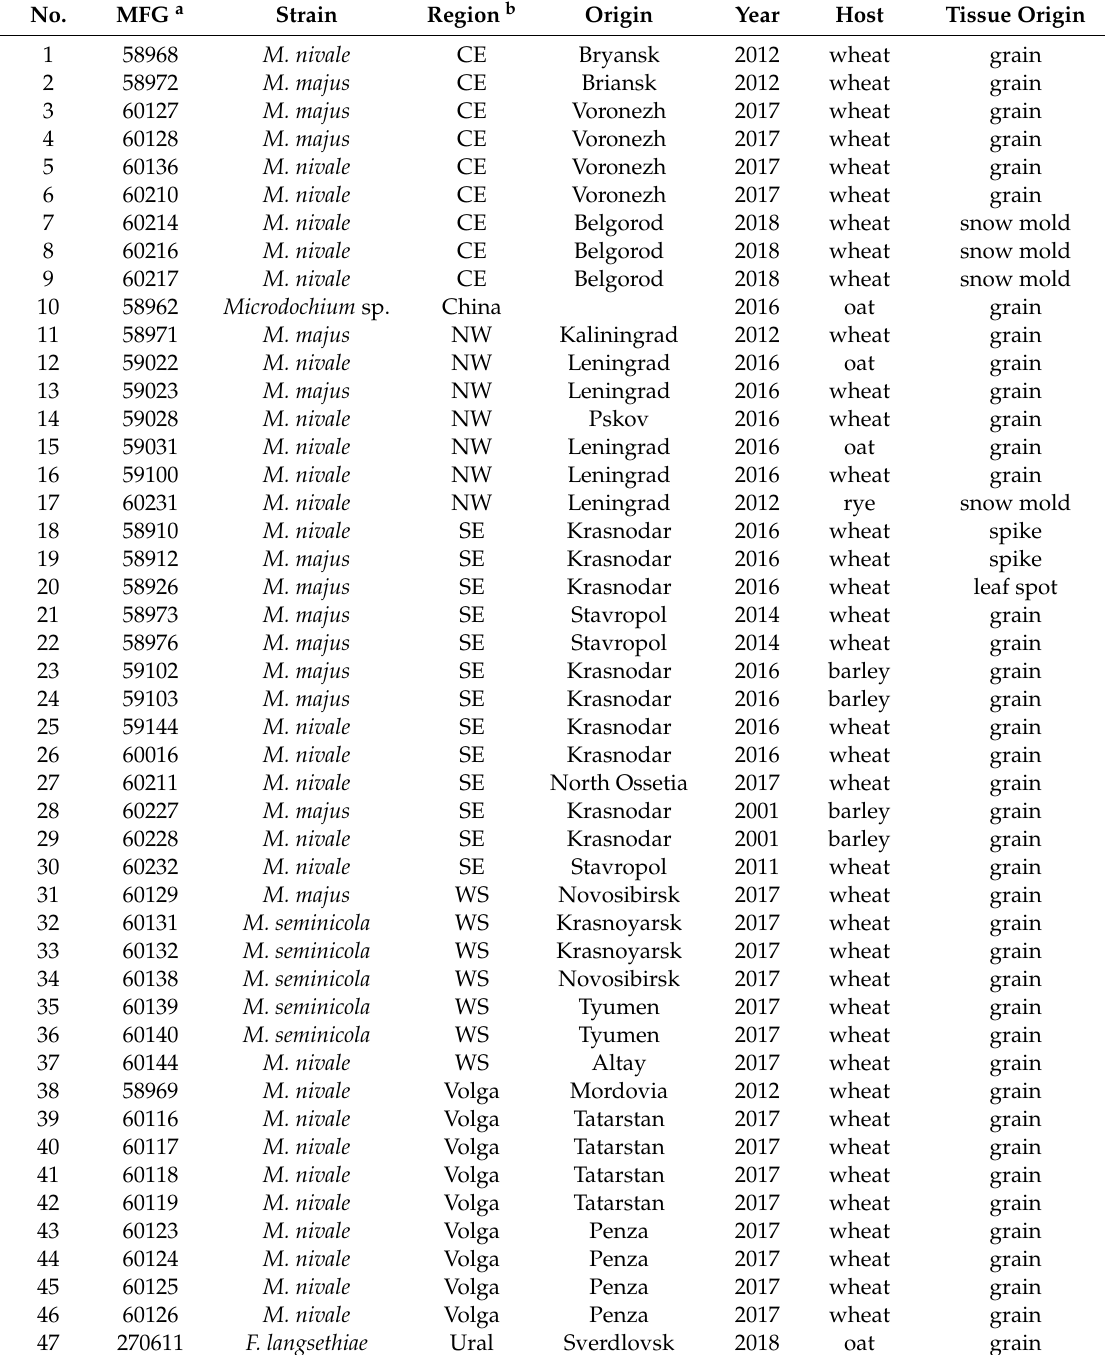
Table 1. Origin of Microdochium and Fusarium strains used in the present work. No. MFG